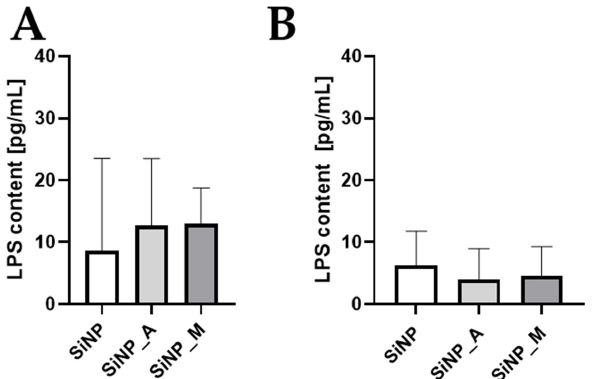
Figure 2. Quantification of LPS content by ( A ) HEK blue assay and ( B ) monocyte activation test (MAT) to analyze LPS contamination in the SiNP samples and Bet v 1. The LPS content was quantified based on LPS standard curves. The data are presented as mean ± SD ( n = 4).